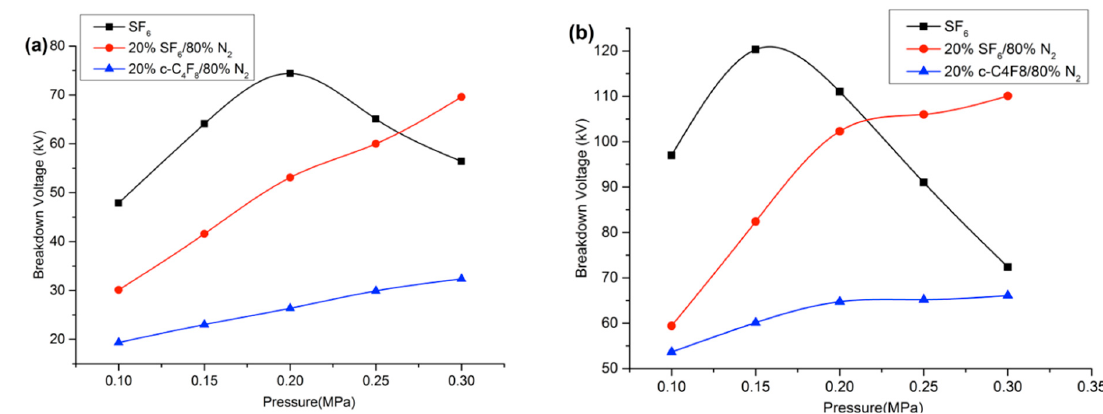
Figure 7. Comparisons of the breakdown voltages of SF 6 , c-C 4 F 8 /N 2 , and 20%SF 6 /80%N 2 in an extremely non-uniform electric field for d of ( a ) 10 and ( b ) 20 mm.